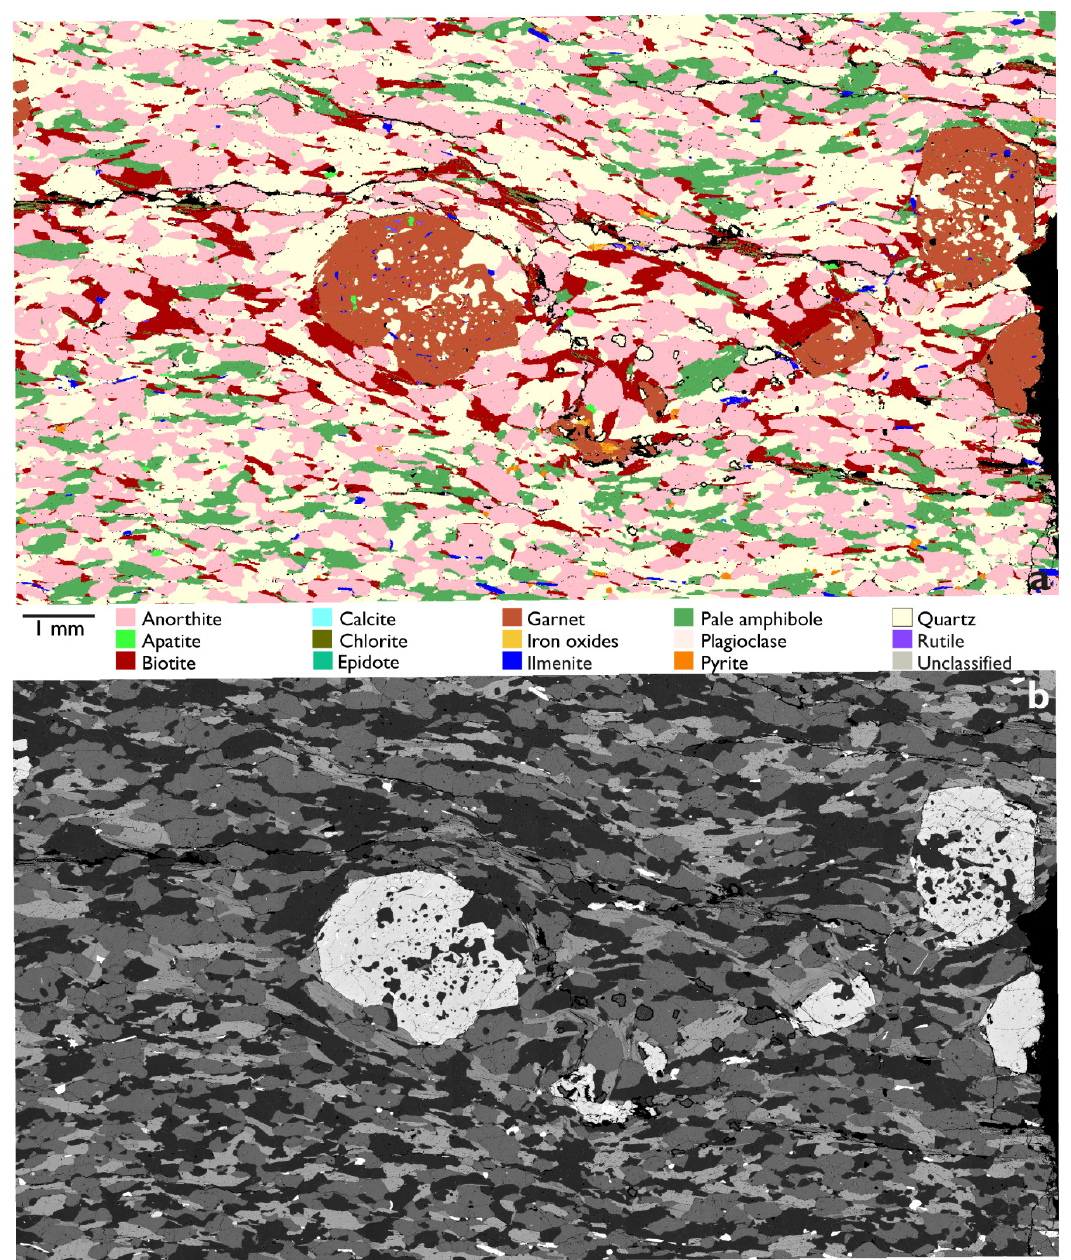
Figure 6. Mineral map ( a ) and BSE micrograph ( b ) for the volcanoclastic sediment with garnet porphyroblasts. The mineral map contains 281714 pixels.